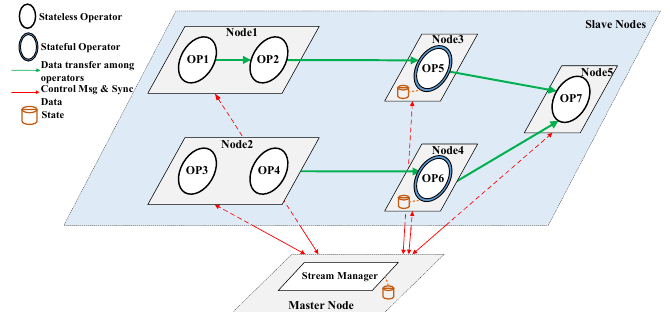
Figure 2. An overview of the DSP computing